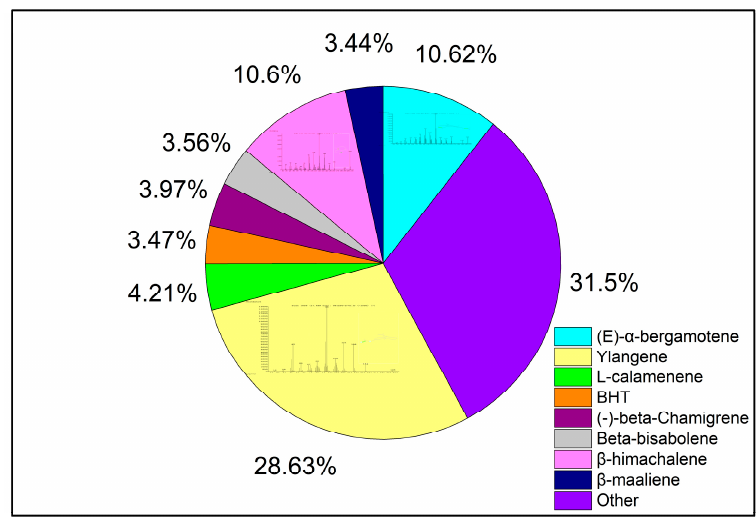
Figure 13. Volatile compounds in S. chinensis obtained by DES UMHD.